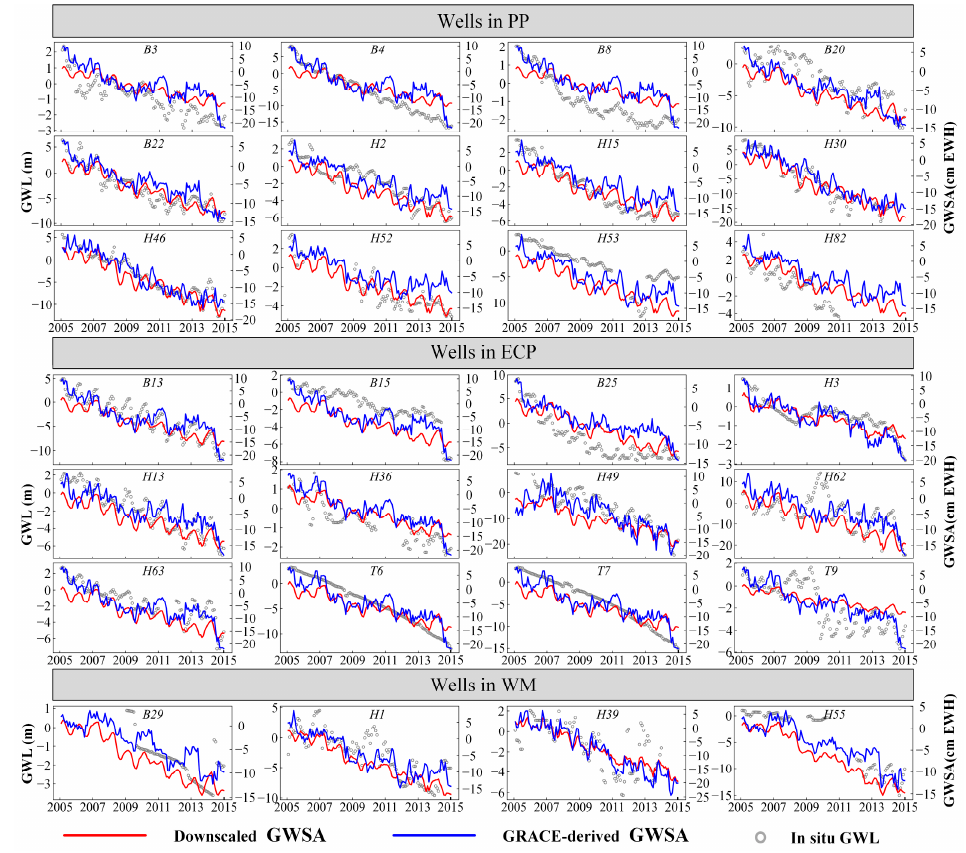
Figure 7. The gray scatters are the monitoring well GWL observations, which have been removed from the average from 2005 to 2009 (orange red dots shown in Figure 1); the red and blue lines represent corresponding monitoring well locations with downscaled GWSA in the 0.05° grid and GRACE-derived GWSA in the 1° grid.